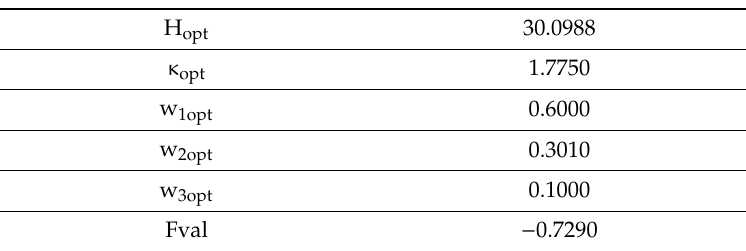
Table 1. The final values of parameters, weights, and objective function. Fval is the final objective function value.